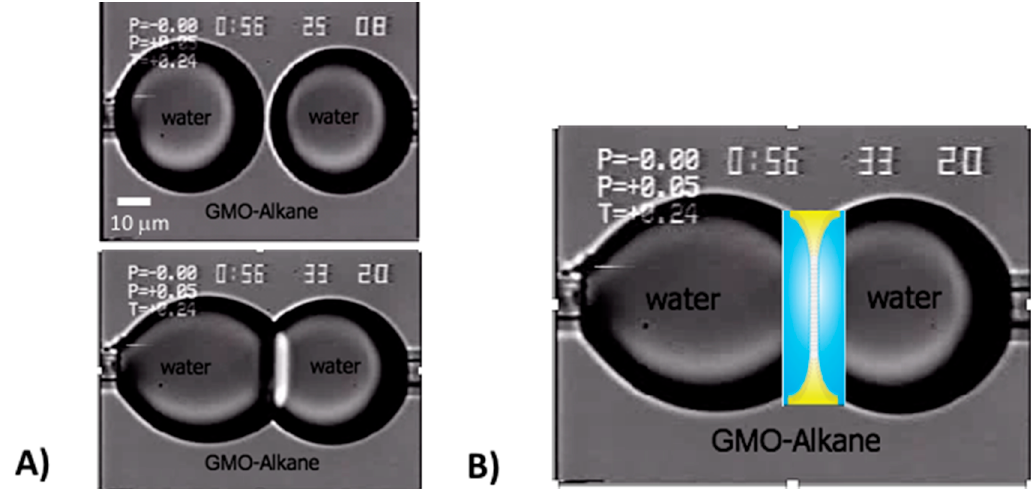
Figure 2. Two opposing water droplets under oil. ( A ) Two water droplets formed (top) in GMO-Alkane solution have a monolayer of GMO at their interfaces. When presented to each other (bottom) using micropipette manipulation they form a GMO-bilayer between them; ( B ) the same image as in (A) (bottom) but now with an overlaid-schematic of the Droplet Bilayer Interface (DIB) showing that a bilayer is formed between them as in the black lipid film.